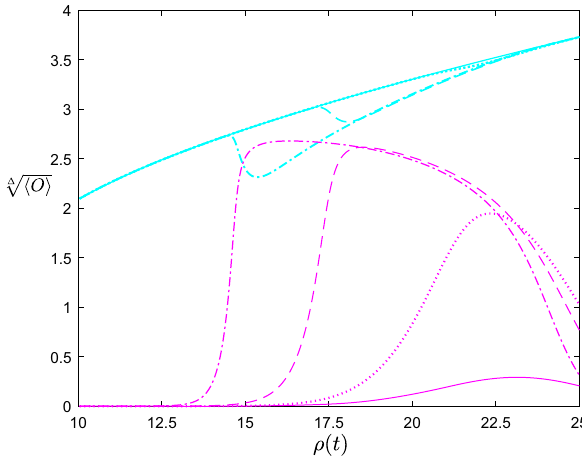
Fig. 5 The τ − q p relation with the final state at ρ e = 25 with the same final state in the sense of static solutions, the different values of q p still make the final states different in the context of non-equilibrium physics. Especially, the quasi- normal modes of the p-wave order depend on q p , therefore the three different quenching processes get different values of relaxing time τ , which can be defined from O − O f ∝ exp ( − t /τ).